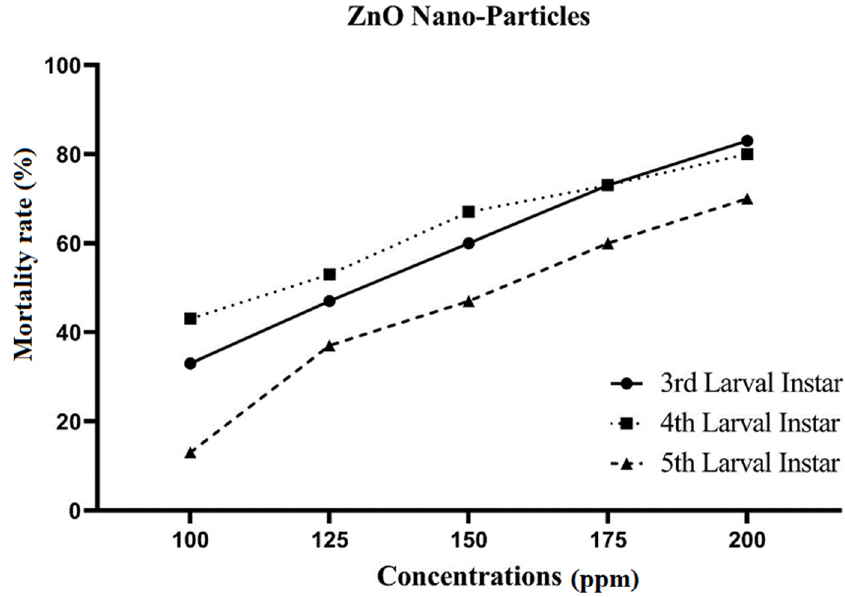
Figure 2. Effect of zinc oxide NPs on the mortality of H. armigera .